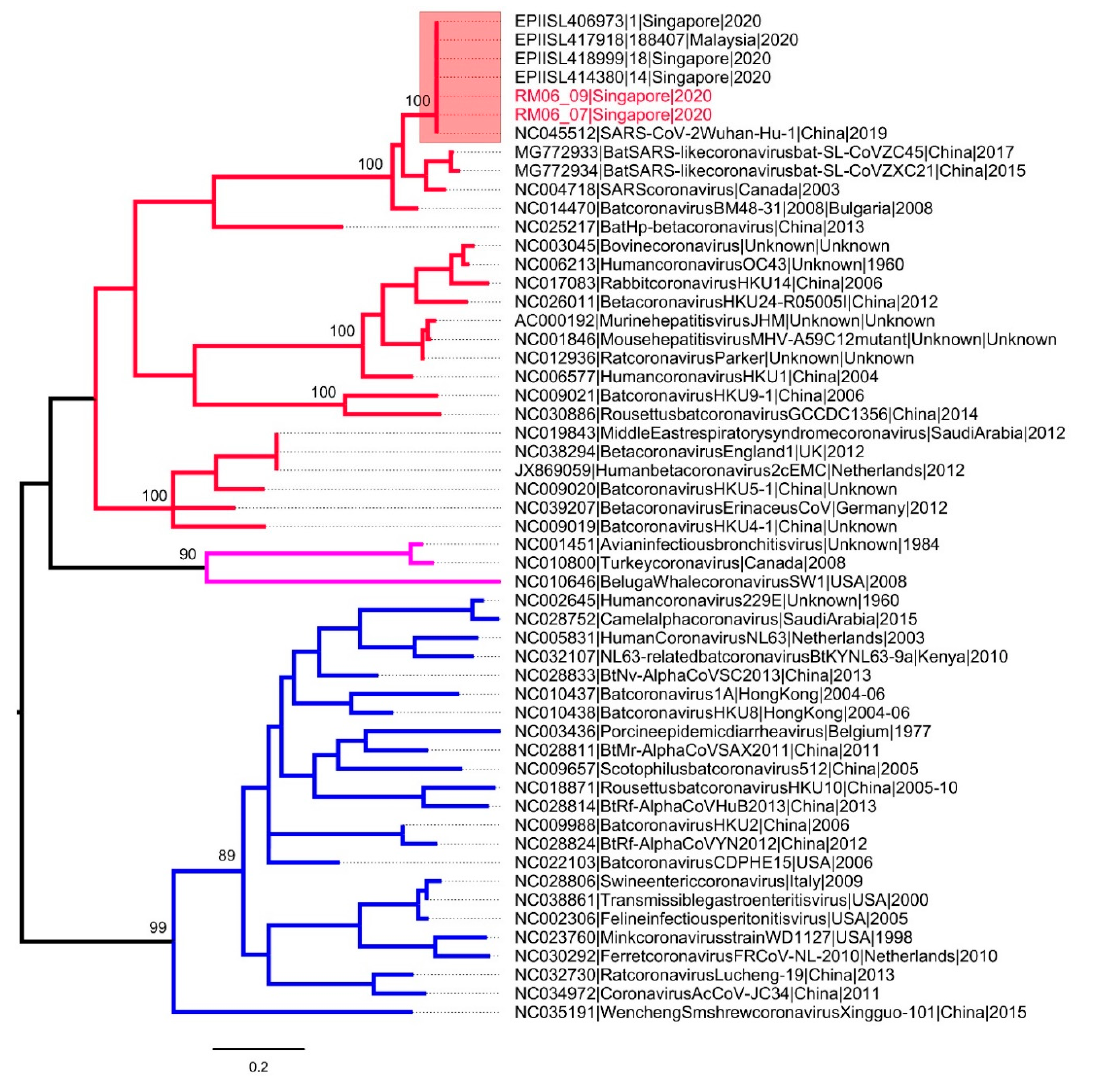
Figure 2. Phylogenetic analysis of RNA dependent RNA polymerase gene (356 bp) of coronaviruses. The maximum likelihood tree was constructed by using the general time reversible substitution model with gamma and invariant site parameters (GTR + Gamma 5 + I). Different groups of coronaviruses are shown in different branch colors; group 1 (blue), group 2 (red) and group 3 (purple). SARS ‐ CoV ‐ 2 sequences are highlighted in the pink box. The taxa names of SARS ‐ CoV ‐ 2 sequences obtained from two positive swabs are highlighted in red. The numbers shown on nodes are bootstrap values. SARS ‐ CoV ‐ 2 was not detected in the majority (99.5%, 426/428) of pre ‐ and post ‐ clean ‐ ing samples. The general low positive rate, even before cleaning and disinfection, demon ‐ strates the challenge in detecting SARS ‐ CoV ‐ 2 in contaminated environments, especially due to the time lapse between exposure and sampling. As environmental samples often contain low amounts of viral RNA, the assays used for the detection of SARS ‐ CoV ‐ 2 need to be highly sensitive. The positive accommodation room was the only site where sam ‐ pling was performed a day after the case vacated the room after spending a day with symptoms. The small area (4 m 2 ) of the affected room might have increased the probability of capturing positive samples. These findings were corroborated by previous evidence of environmental contamination on beddings of quarantine rooms [24], as well as on a cruise ship where SARS ‐ CoV ‐ 2 RNA was detected mostly in enclosed cabins and toilets [25]. Although the use of a viral RNA detection method does not always correlate with virus integrity, viability or infectivity [26], a few reports have successfully cultured the